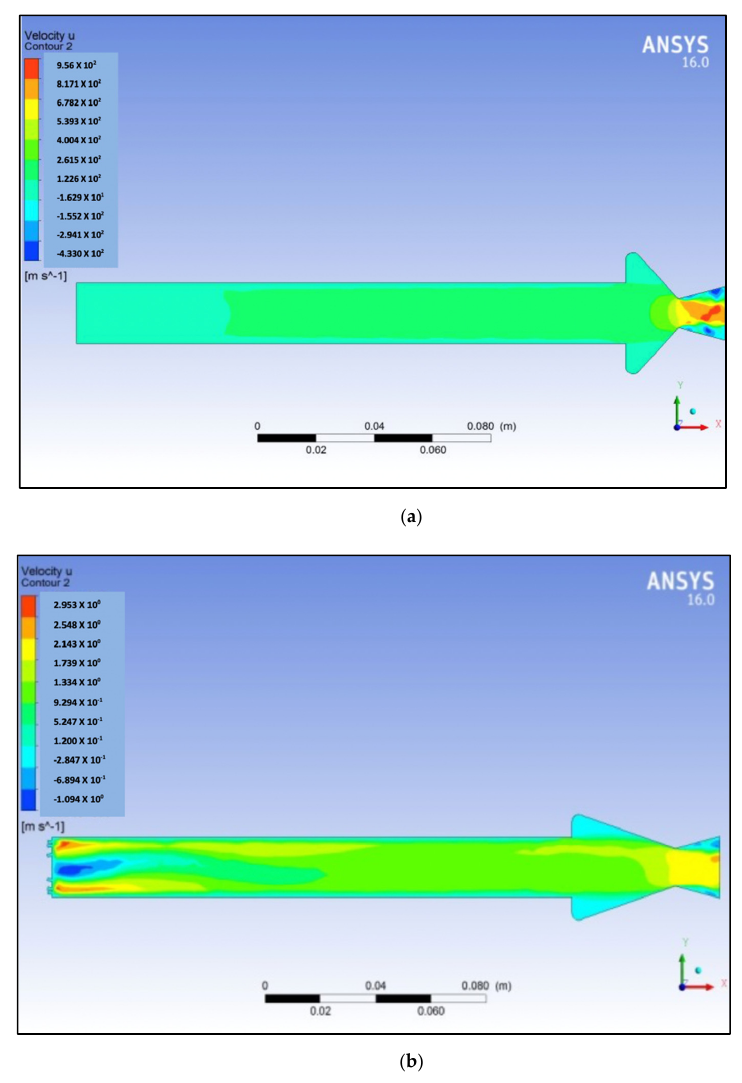
Figure 6. Axial velocity contour using ( a ) shower head injector and ( b ) multi-angle diverging injector.